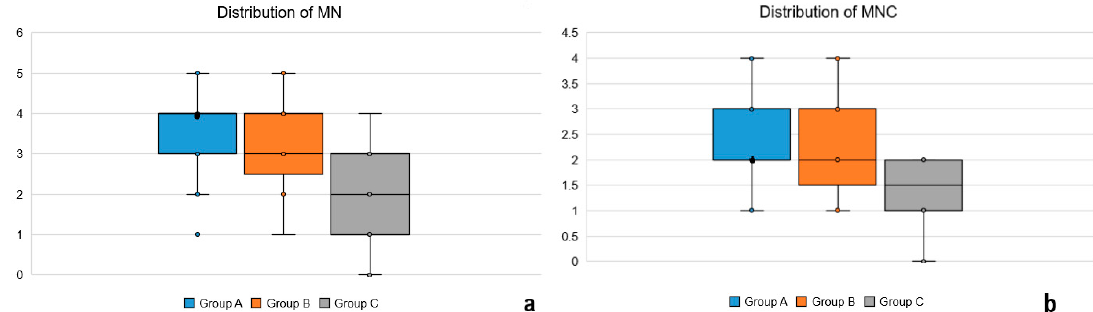
Figure 3. ( a ) Boxplot illustrating the distribution of MN among the three study groups; the median of Group A was identical with the value of quartile 3; ( b ) Boxplot illustrating the distribution of MNC among the three study groups; the median of Group A was identical with the value of quartile 1.